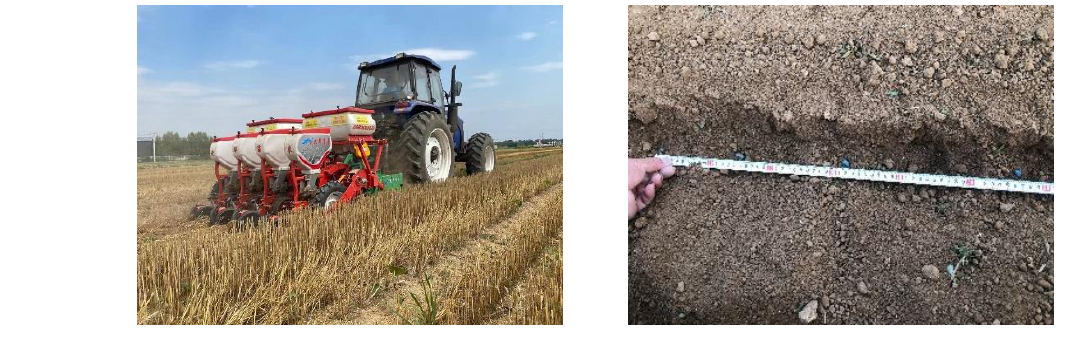
Figure 11. Experiment field of the WNPM seeder.